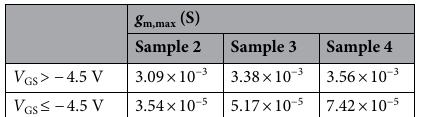
Table 1. The calculated maximum transconductance of samples 2, 3, and